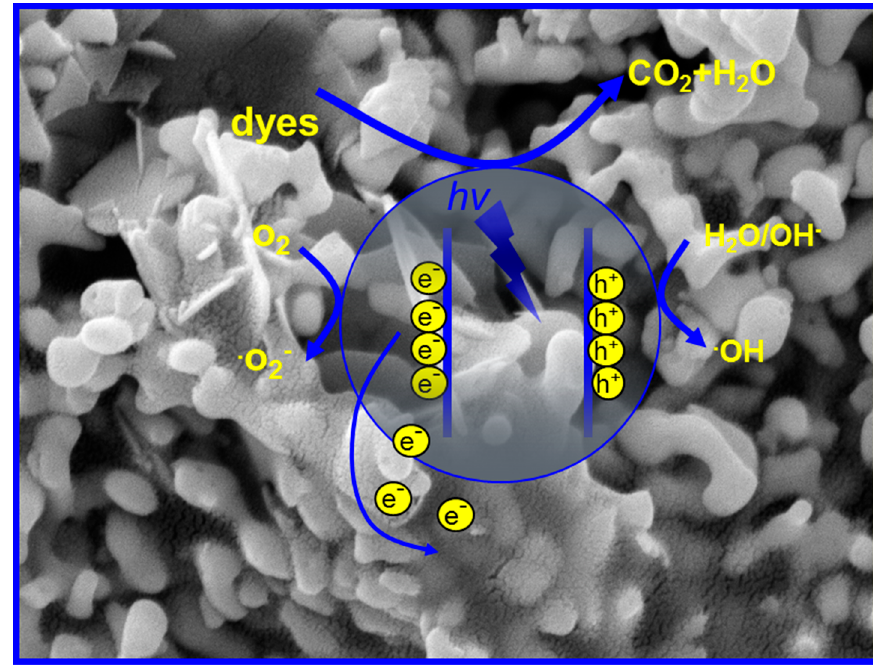
Figure 6. Speculation schematic of β -Bi 2 O 3 /GN photocatalytic degradation mechanism of dye.